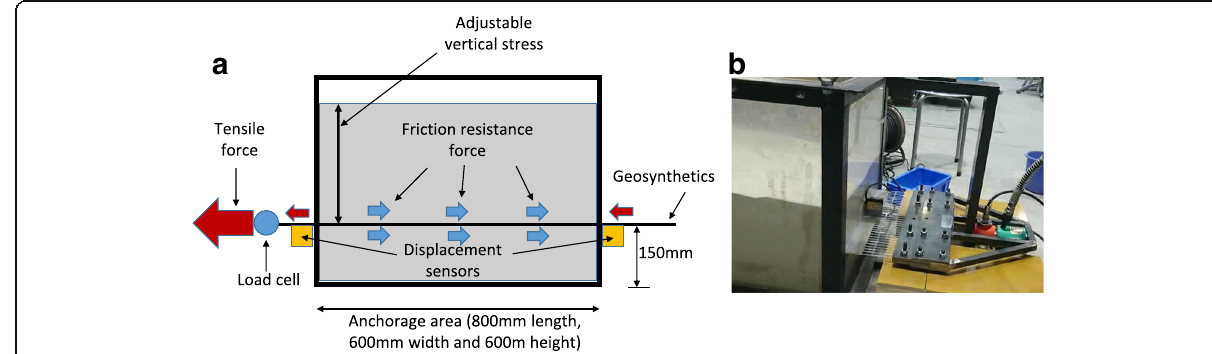
Fig. 4 Pull-out test apparatus. a Side view of the pull-out test apparatus; b A photograph of the pull-out test